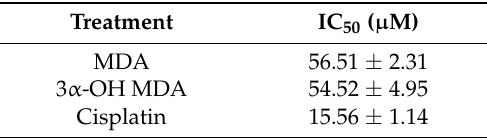
Table 2. Effect of MDA and 3 α -OH MDA on body weight of mice. The data are shown as the means ± SEM (standard error of mean) with n = 6 animals for each experimental group. ** p < 0.01 represent the statistical difference in body weight change between the beginning and end of treatment. Data were analyzed by one-way ANOVA-repeated measures.